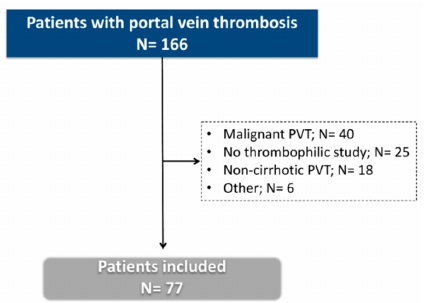
Figure 1. Flowchart of the study selection process. PVT: portal vein thrombosis.